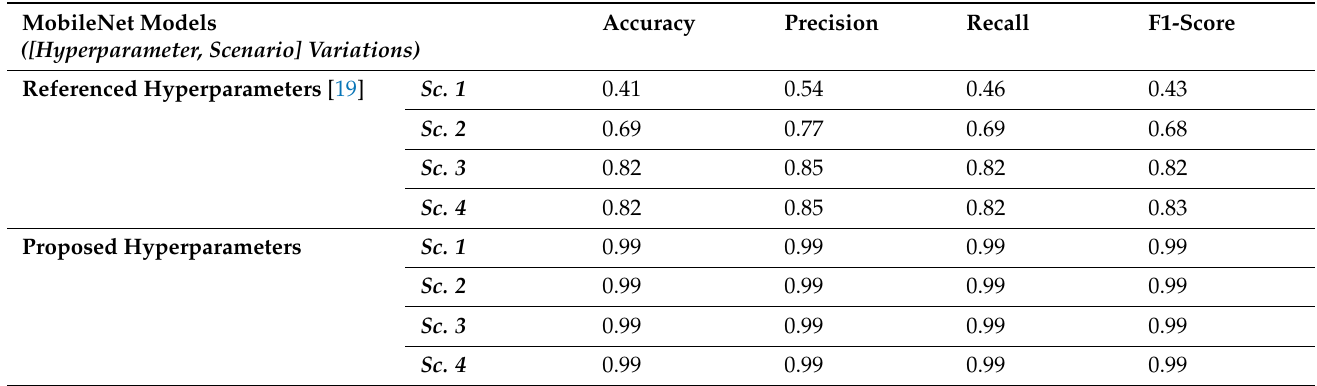
Table 1. Evaluation scores for developed MobileNet